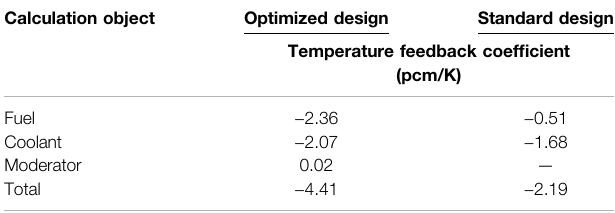
TABLE 10 | Temperature feedback coef fi cient of optimized